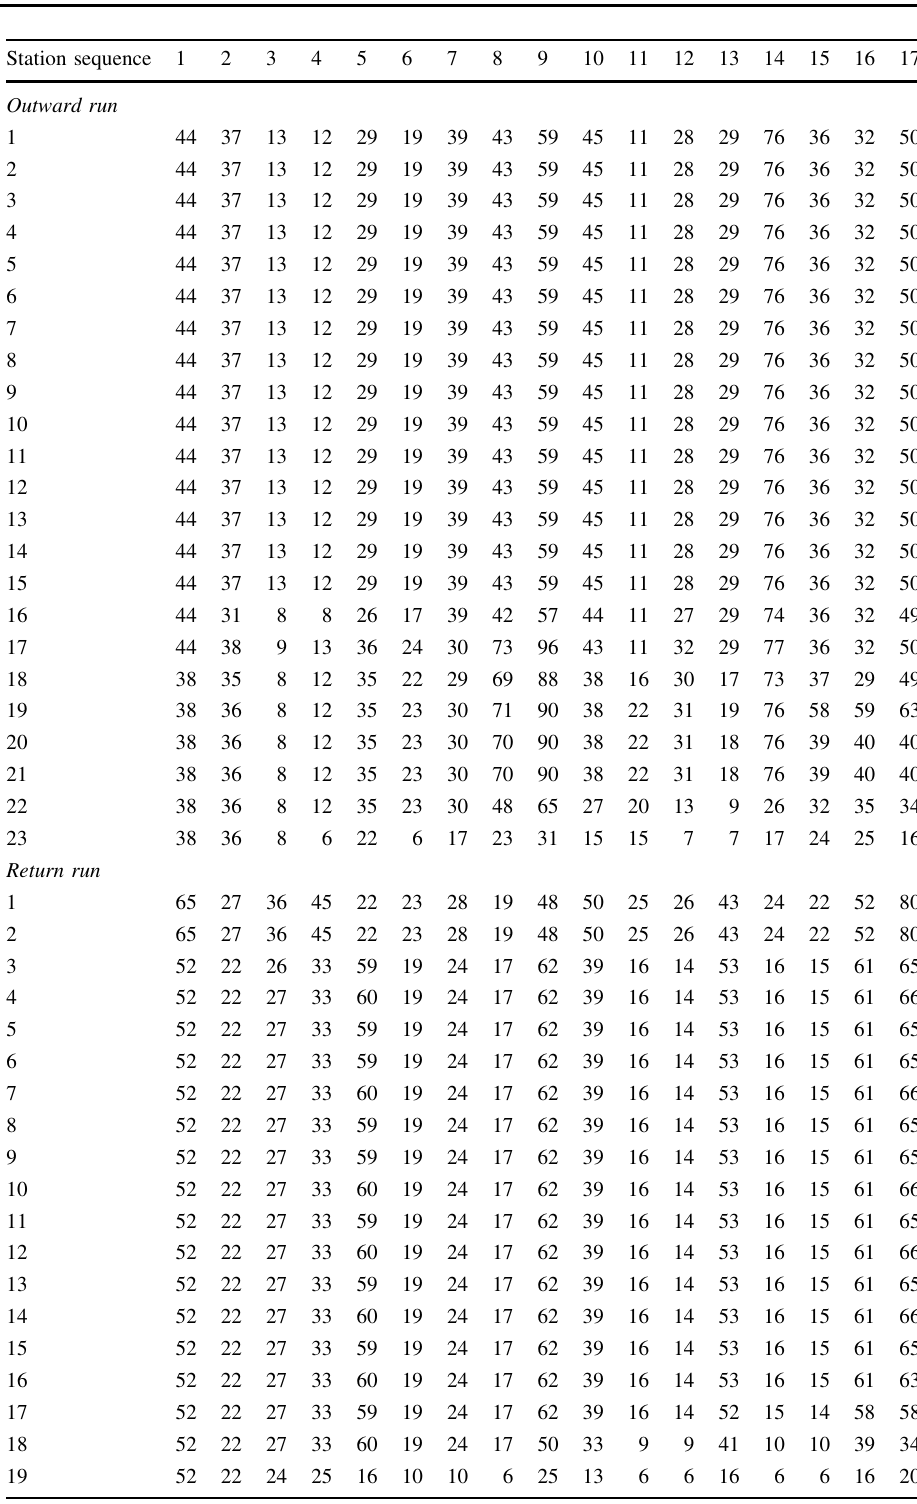
the complexity unpredictable evolution.